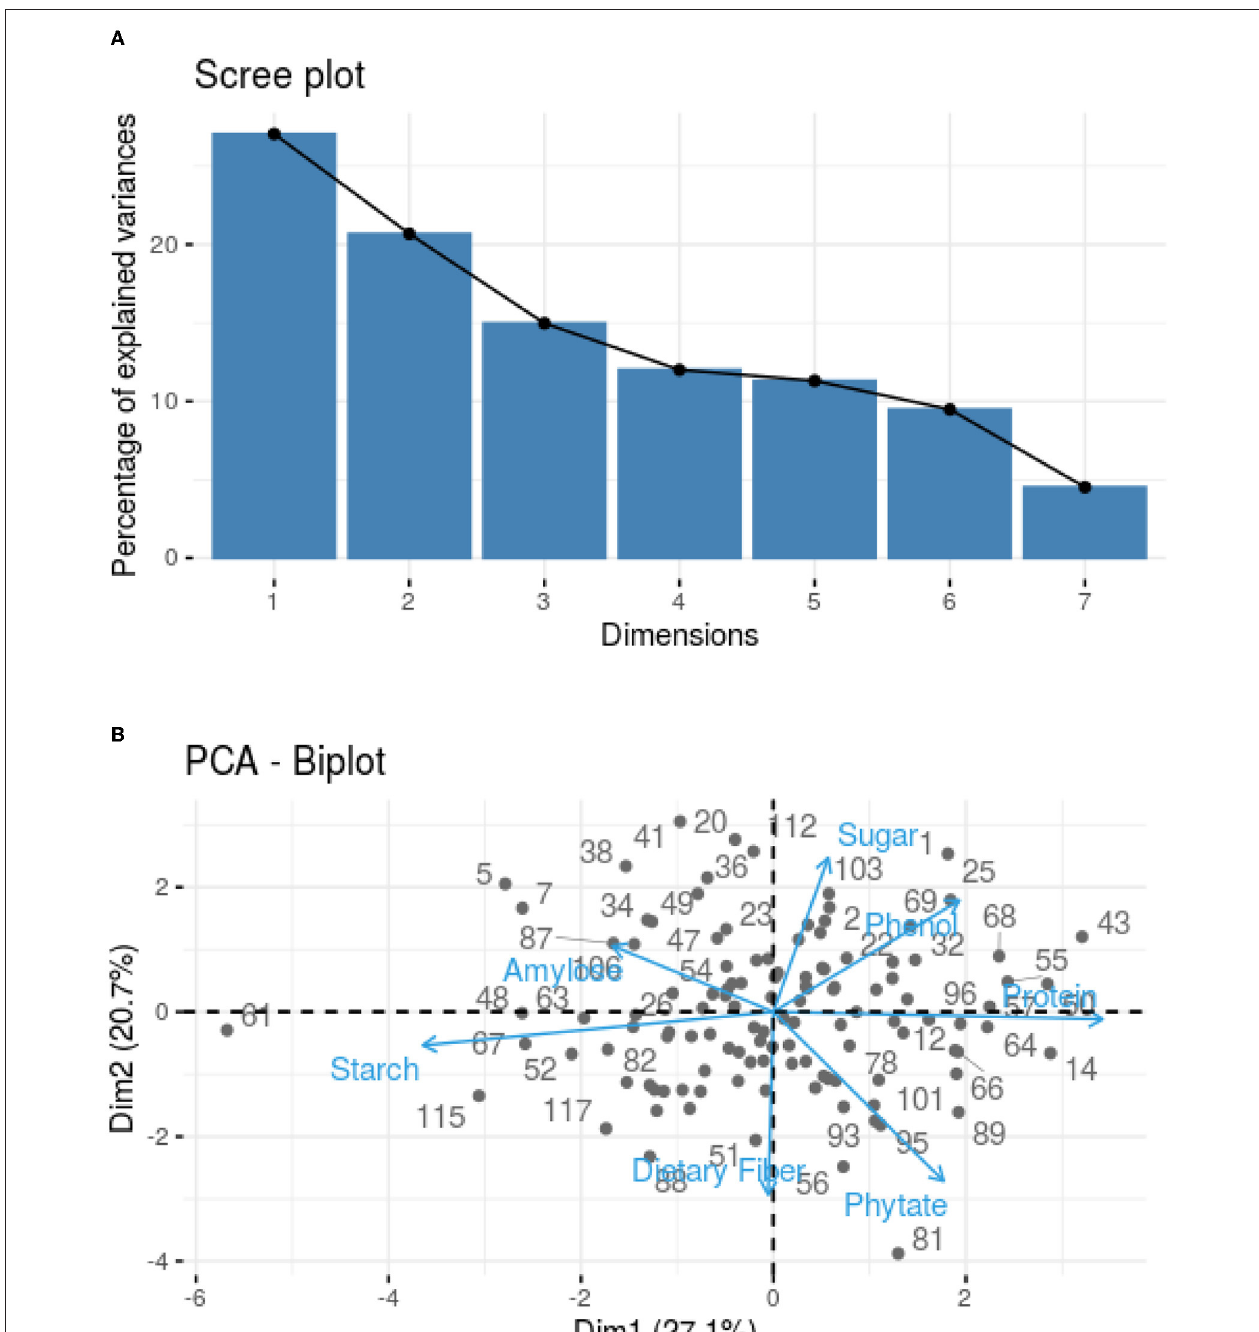
FIGURE 1 | (A) Scree plot explaining principal component variances in terms of components. (B) PCA biplot indicating the distribution of nutritional traits in 120 samples based on their calculated component loading values for phytic acid, starch, phenols, TSS, protein, TDF, and amylose.